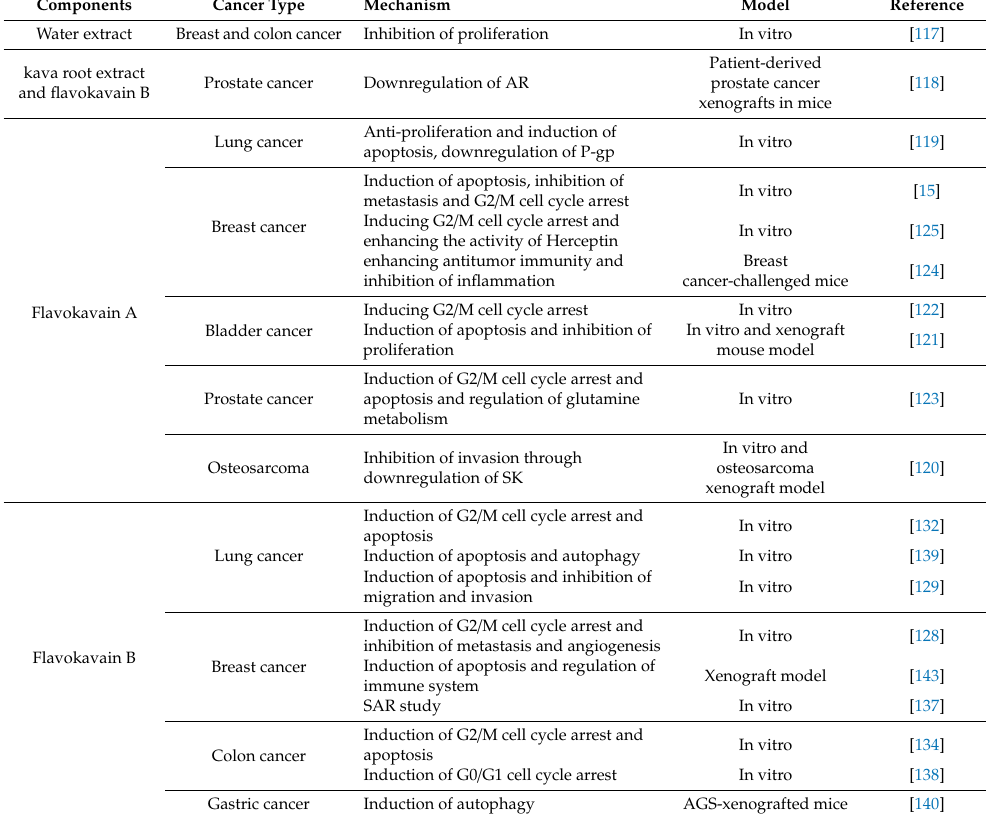
Table 6. Kava and its components in cancer